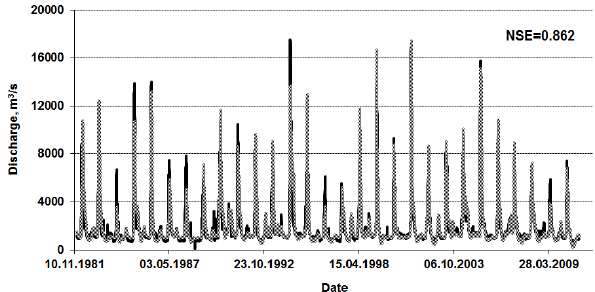
Figure 2. Observed (black line) and simulated (gray line) hydro- graphs of unregulated lateral water inflow into the Cheboksary